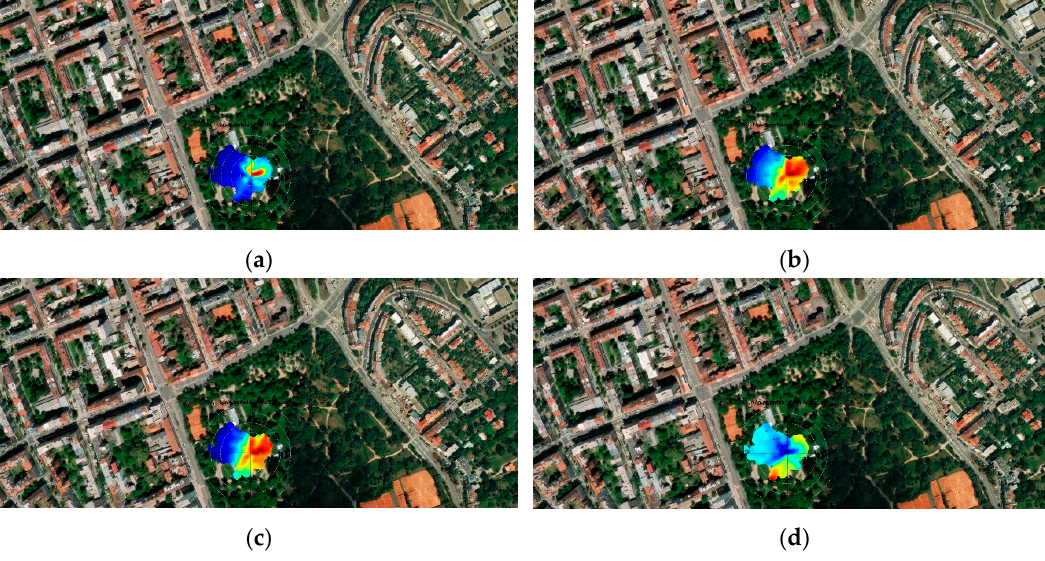
Figure 12. The NO ( a ), NO 2 ( b ), PM 10 ( c ), and O 3 ( d ) concentration relationships to the wind speed and direction at Lužánky SVC; sampling started on 12.9.2018 12:00. Figure 12a indicates that the highest NO concentrations were measured with a east